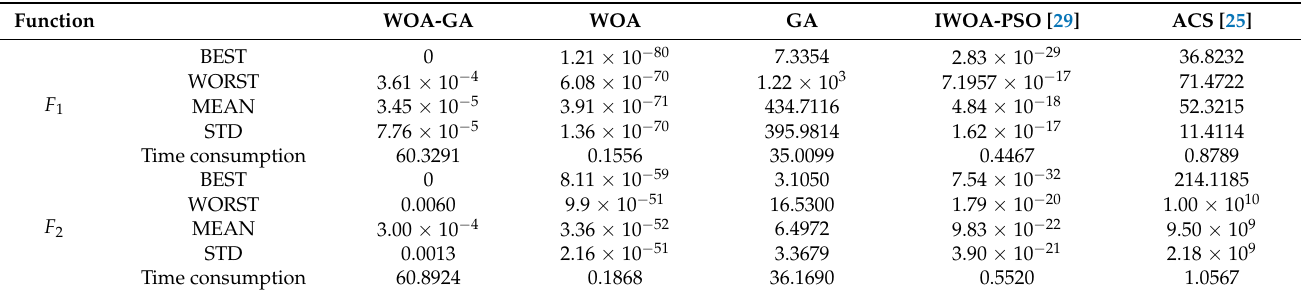
Table 5. Comparisons of the optimization results for the unimodal